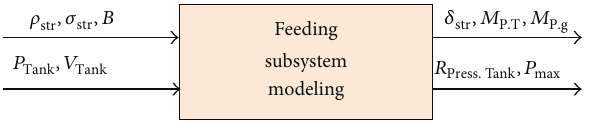
Figure 5: Input-output flow data of feeding subsystem modeling.